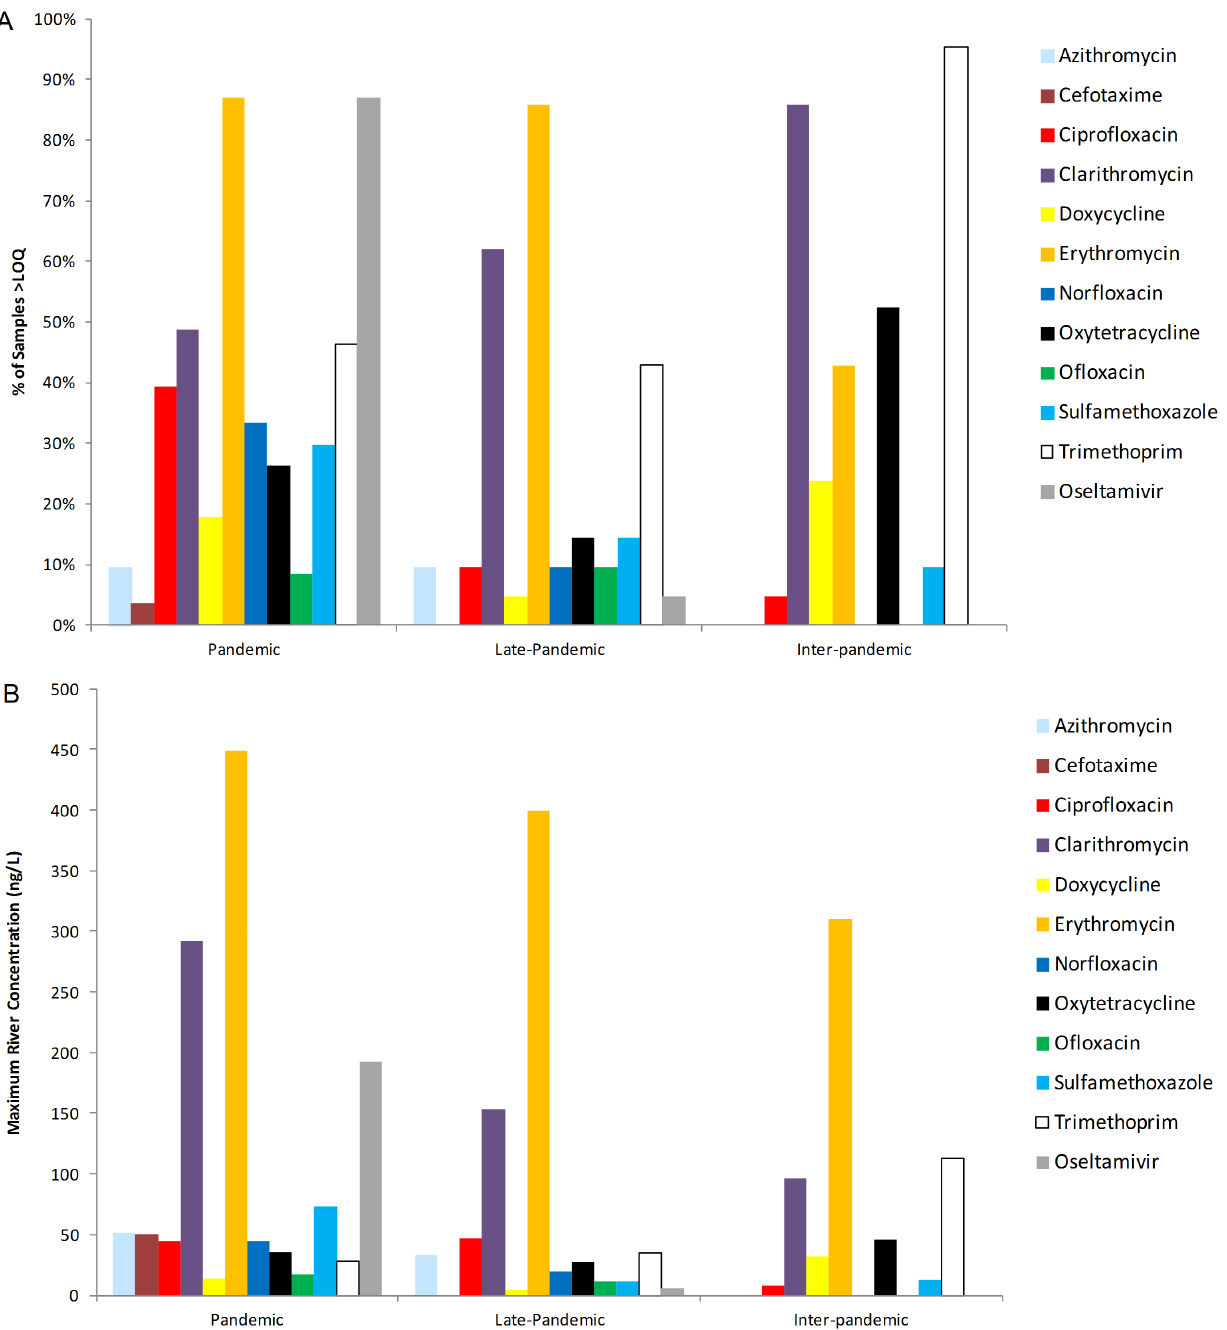
Figure 5. Comparison of pharmaceutical (A) abundance (% of samples above the limit of quantification (LOQ)) and (B) the maximum river concentration (ng/L) during the pandemic period (November, 2009), late pandemic period (March 2010) and the inter-pandemic period (May 2011).